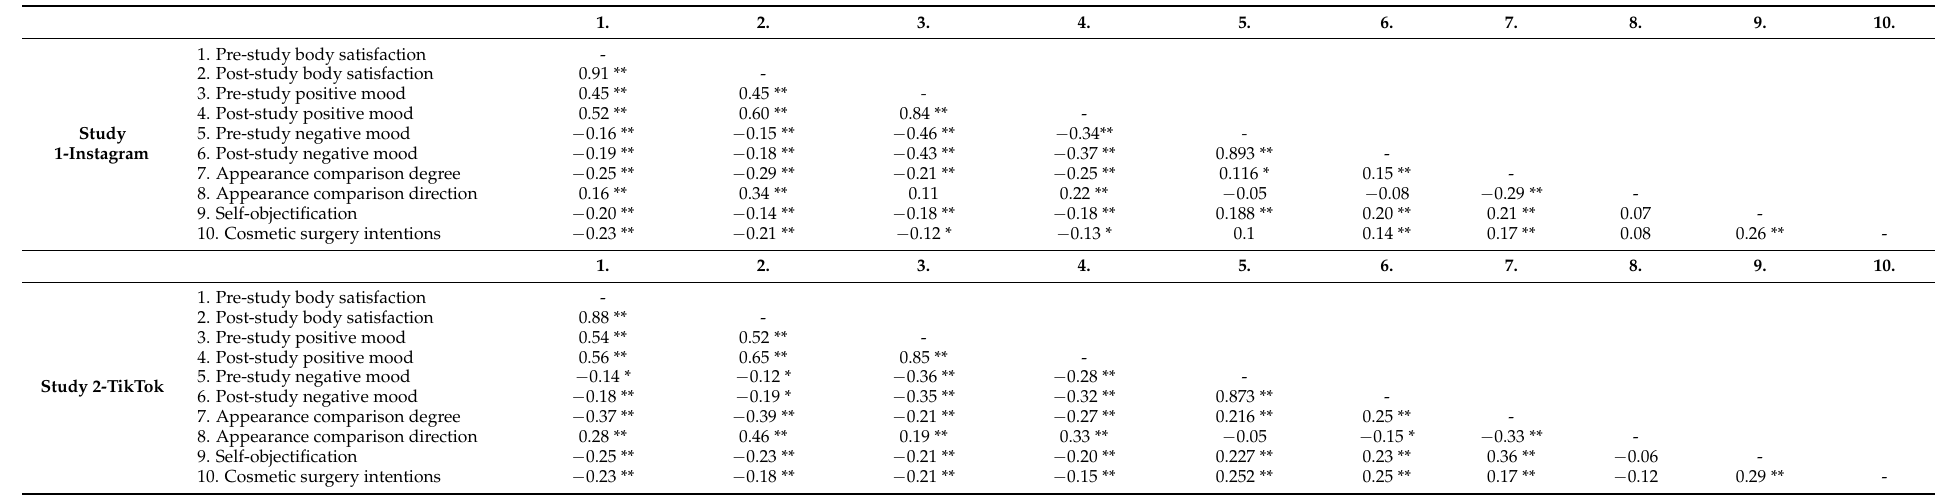
Table 3. Zero-order Correlations among all the variables separated for Study 1 and Study